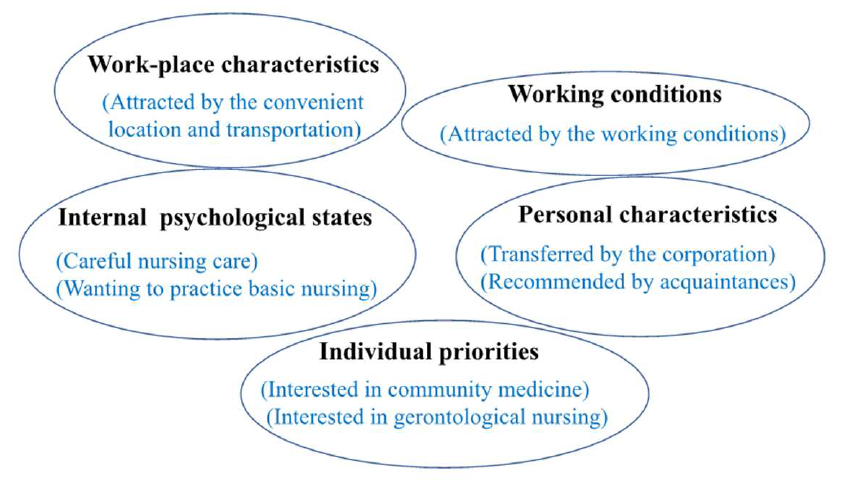
Figure 2. Logical Figure 2. Logical validity.